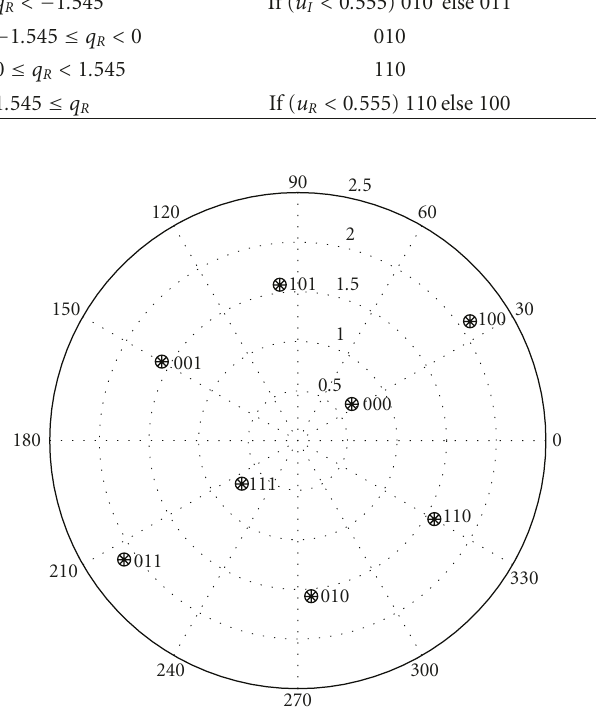
Figure 5: Joint constellation for the three transmitters scenario.